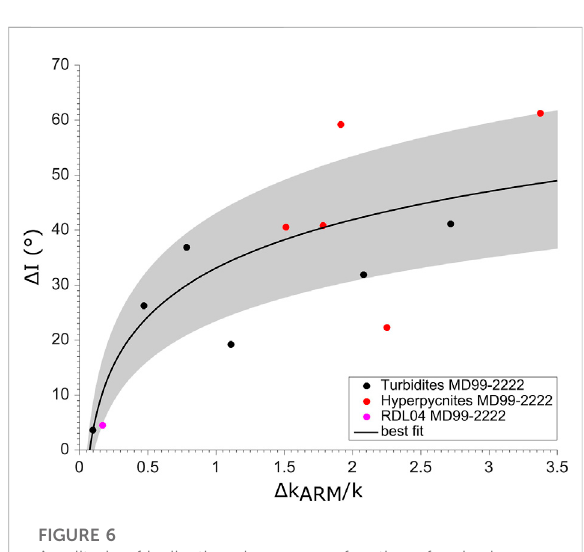
FIGURE 6 Amplitude of inclination changes as a function of grain size changes within 12 RDLs. Same symbols as in Figure